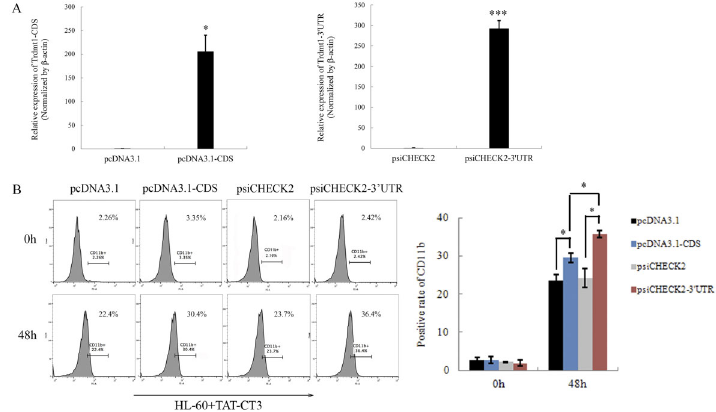
Figure 2. A, The expression levels of Trdmt1 3 0 untranslated region (UTR) and coding sequence (CDS) in HL-60 cells transfected with a construct expressing Trdmt1 3 0 UTR (psiCHECK2-3 0 UTR), Trdmt1 CDS (pcDNA3.1-CDS), and control (psiCHECK2 and pcDNA3.1). B , Flow cytometry analysis of CD11b expression in HL-60 cells transfected with a construct expressing Trdmt1 3 0 UTR (psiCHECK2- 3 0 UTR), Trdmt1 CDS (pcDNA3.1-CDS), and control (psiCHECK2 and pcDNA3.1). Data are reported as means ± SD. *P o 0.05; ***P o 0.001 (ANOVA or Student ’ s t